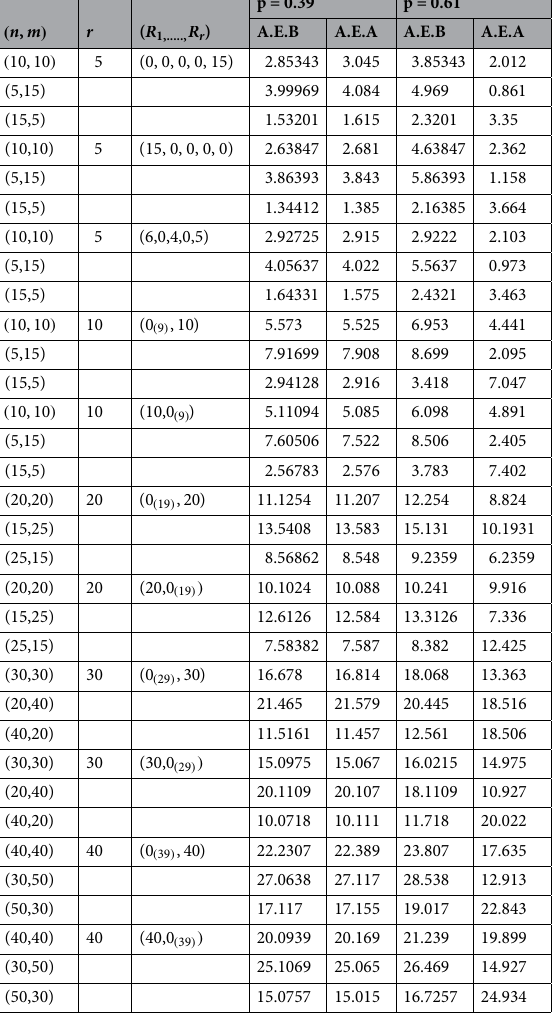
Table 9. The comparison between A.E.B and